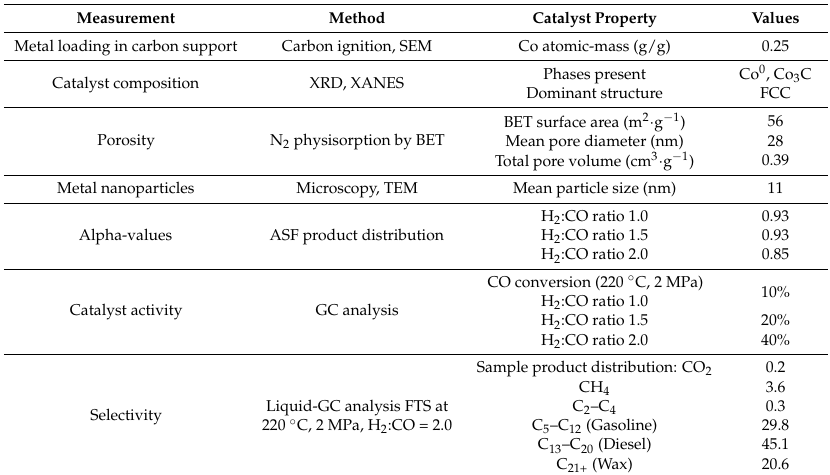
Table 4. Summary details of the properties of the plasma synthesized Co/C